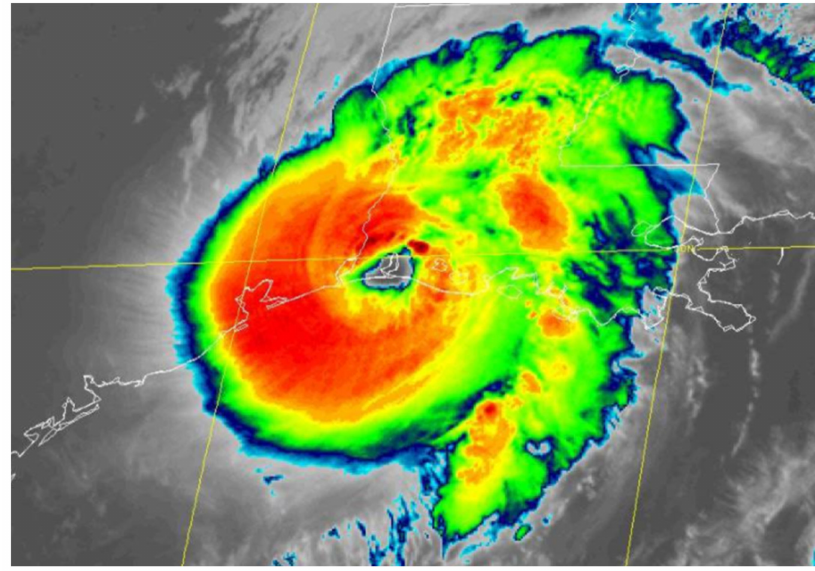
Figure 3. Hurricane Laura, USA,